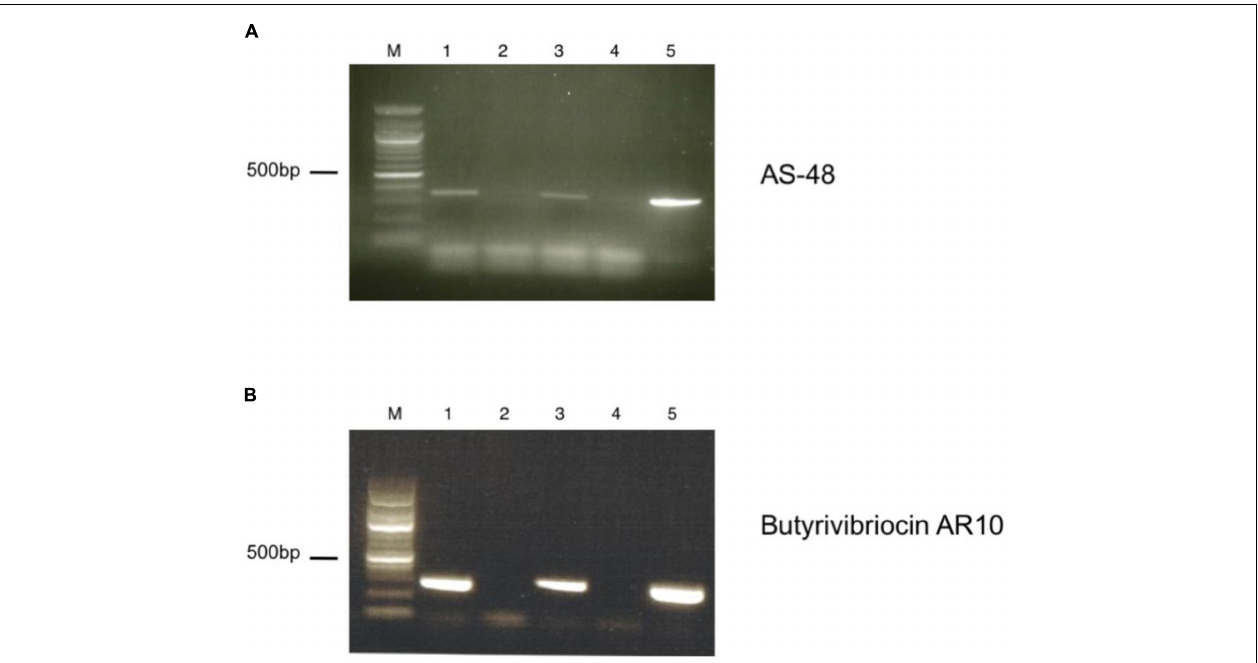
FIGURE 4 | RT-PCR of putative bacteriocin-like genes present in the genome of C3. (A) Detection of AS-48 bacteriocin transcript by RT-PCR. Lanes are as indicated: M. Marker, (1) +RT (TH media), (2) -RT (TH media), (3) +RT (TH media supplemented with BSA), (4) -RT (TH media supplemented with BSA), (5) Positive